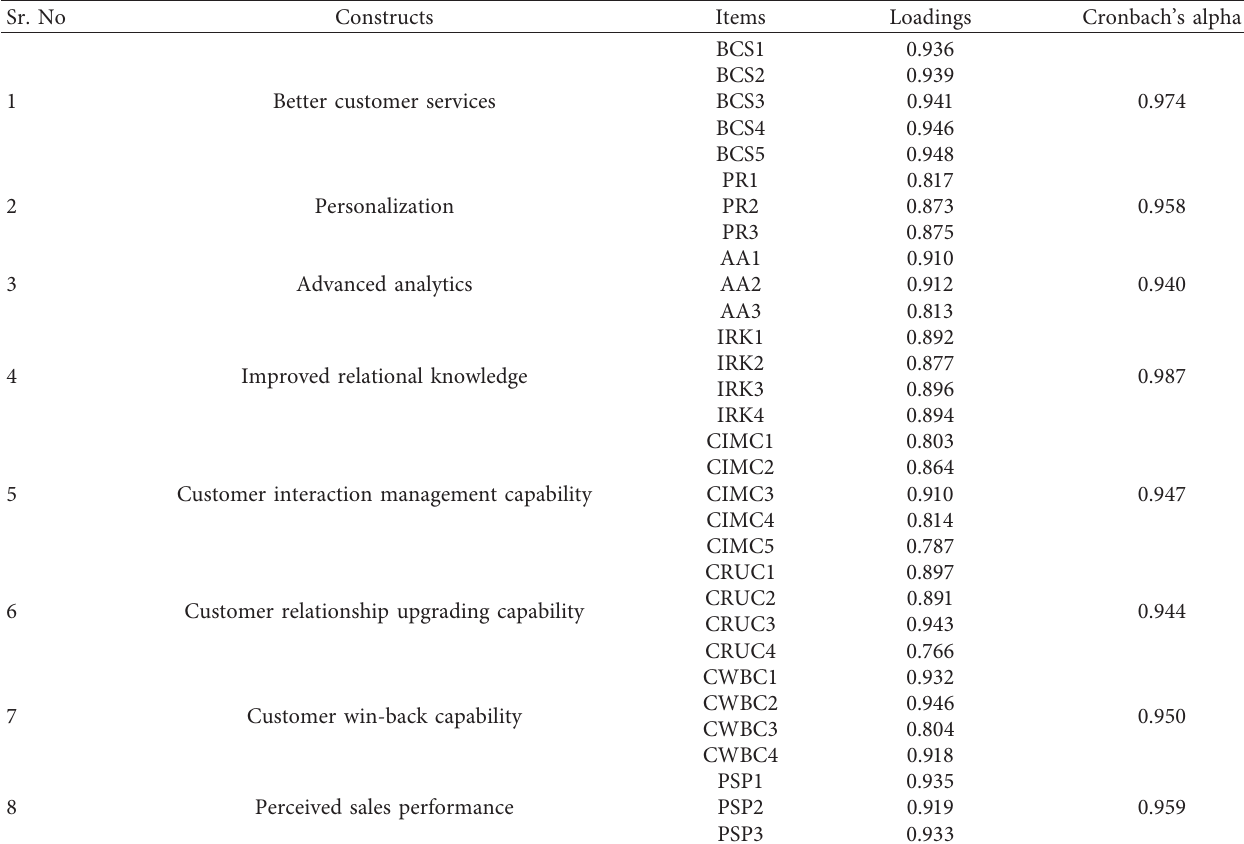
Table 3: Pilot testing results.